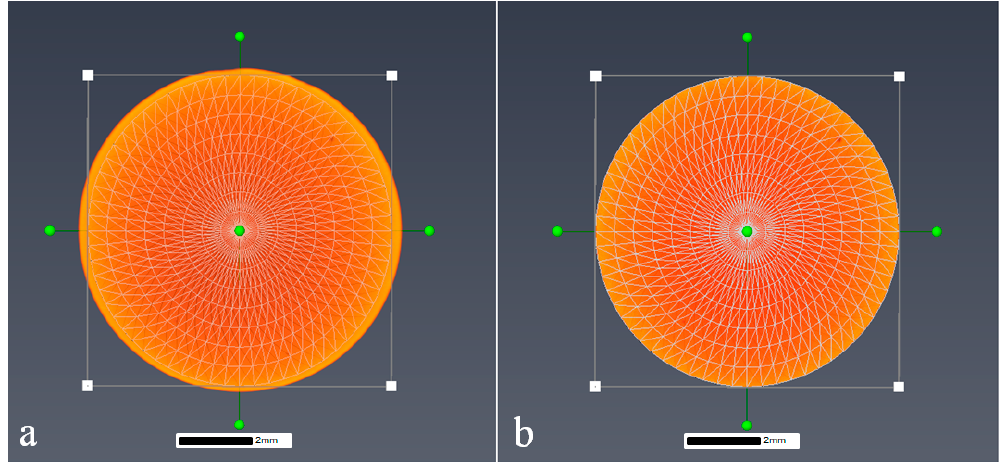
Figure 5. Image showing a volume render of the small punch specimen both ( a ) before and ( b ) after trimming in Avizo 9.0.